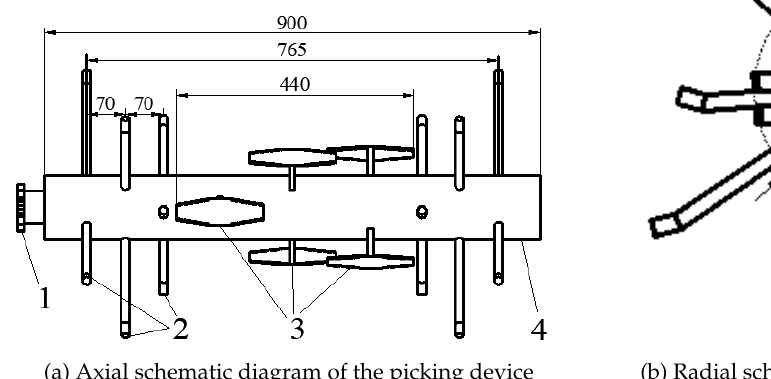
Fig. 3. Schematic diagram of picking device